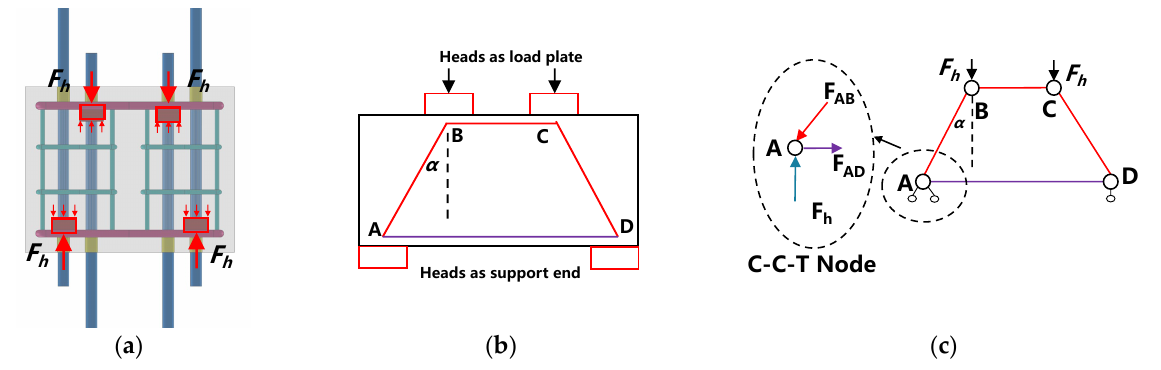
Figure 38. Strut-and-tie model ( a ) Force at heads; ( b ) STM model; ( c ) C-C-T node. Under the tension of headed bars, the heads are under compression. The heads are